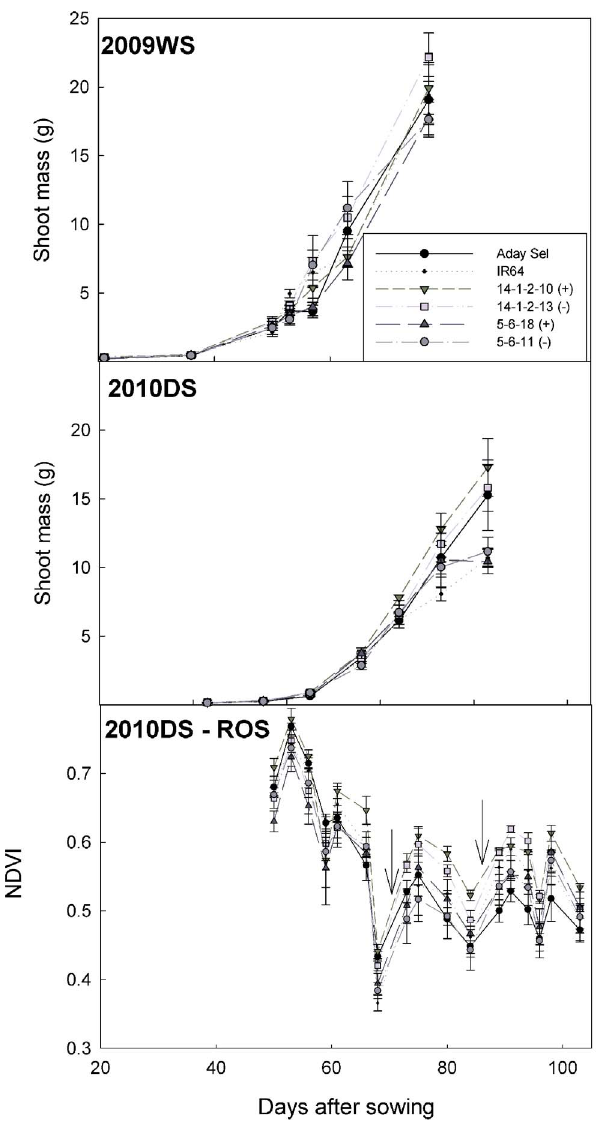
Figure 2. Shoot growth dynamics in field studies as measured by destructive sampling in 2009WS and 2010DS seasons, and by NDVI in 2010DS-ROS. Arrows indicate dates that the experiment was re-watered. No significant differences were observed between lines within a BIL pair on any sampling date.